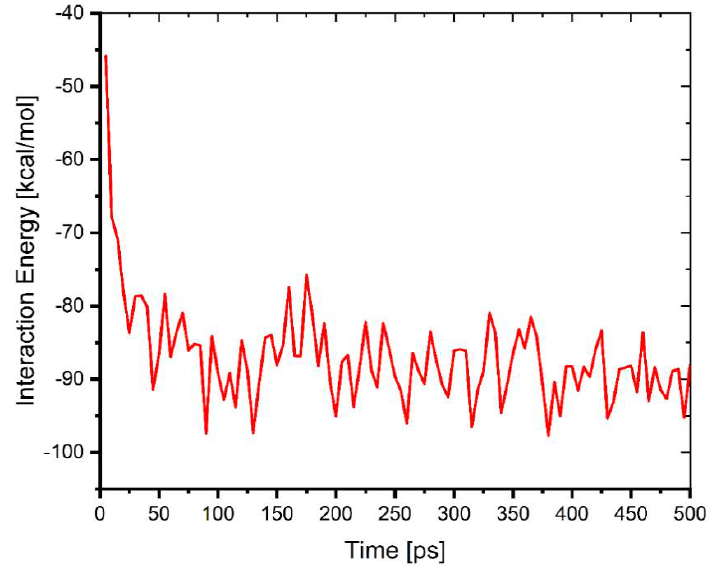
Figure 18. Time-lapse configurations of the interaction of the difenoconazole molecule onto Cell-X surface obtained by MD.